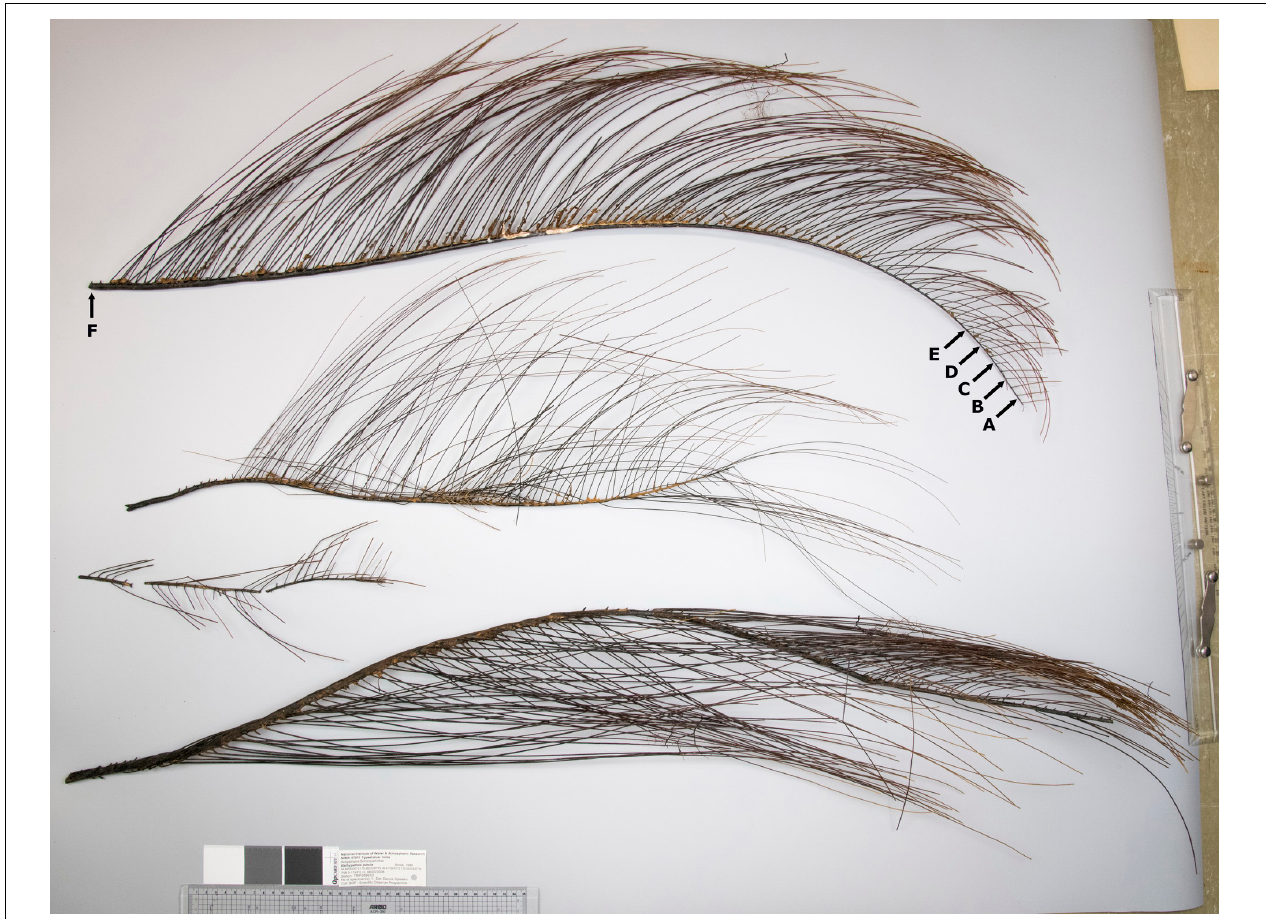
FIGURE 5 | Bathypathes patula NIWA47911. Specimen showing where samples were extracted for analysis. (A) is the growing tip, (F) the basal section and, (B–E) are intermediate sample sites taken to look for the radiocarbon bomb signal. Specimen from Chatham Rise, New Zealand. Scale bar is a 35 cm